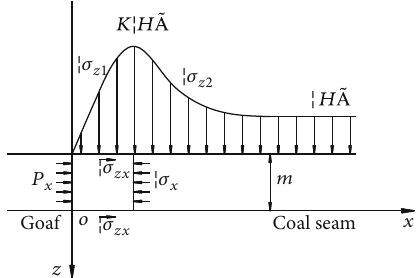
Figure 3: Mechanical model of support stress distribution in front of working